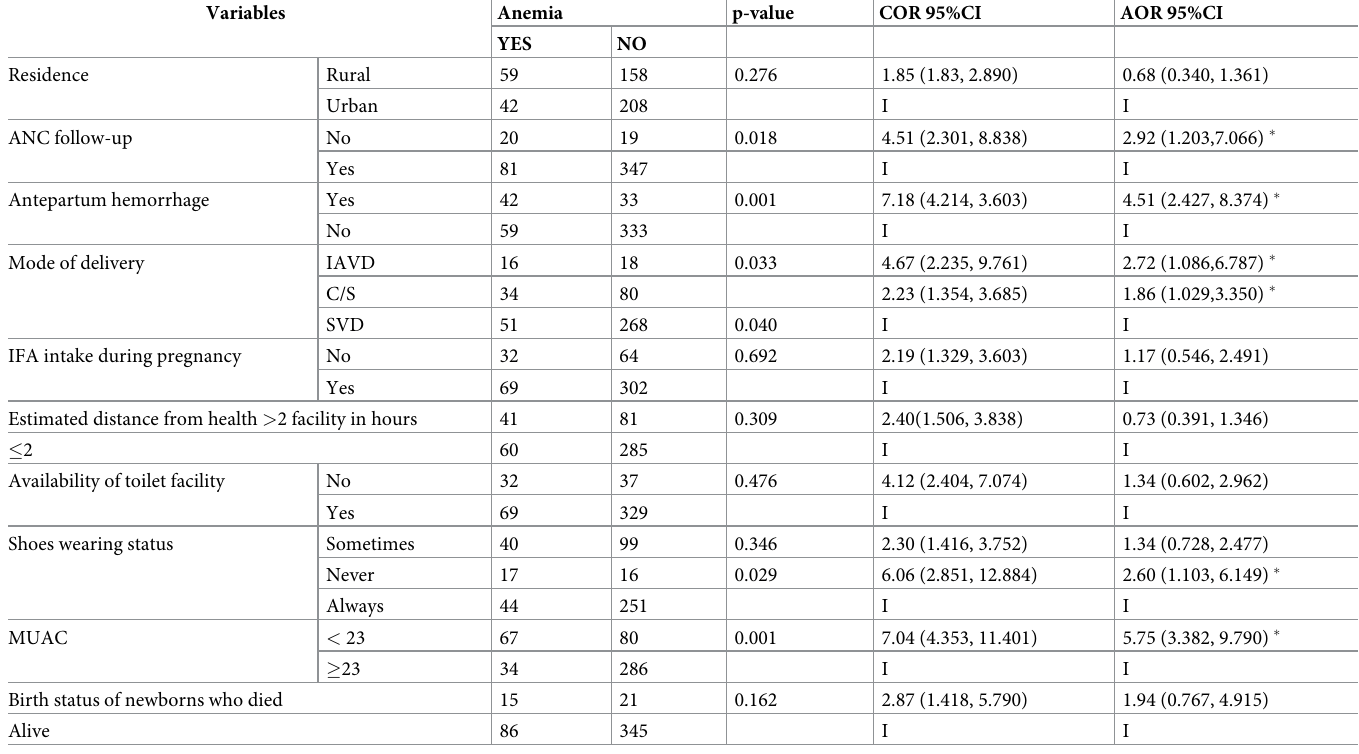
Table 4. Bivariable and multivariable logistic regression analysis of factors associated with immediate postpartum anemia in East Gojjam zone hospitals Northwest Ethiopia 2020 (n = 467).